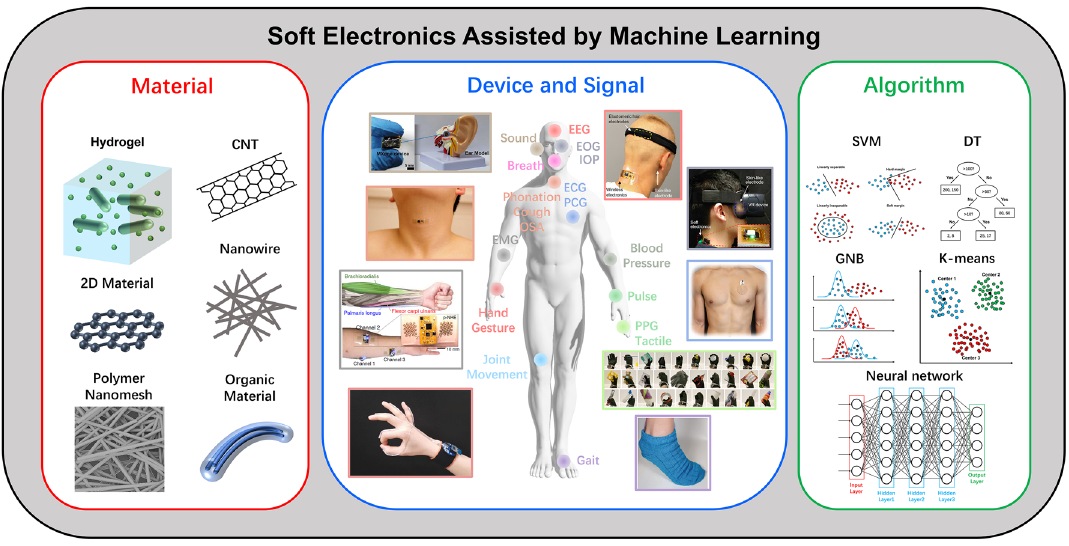
Fig. 1 Many new soft materials (2D material, CNT, nanowires, polymer nanomesh, hydrogel, etc.) have been applied to monitor physiologi- cal signals, such as EEG, EOG, IOP, breath, ECG, joint movement, blood pressure, pulse, photoplethysmography (PPG), EMG, and gait. The soft physiological monitoring system can be more and more intelligent assisted by algorithms such as SVM, DT, GNB, K-means, and neu- ral network. Reproduced with permission [26–29]. Copyright (2016), (2020), (2022), American Association for the Advancement of Science. Reproduced with permission [30–33]. Copyright (2019), (2020), (2021), Nature Publishing Group. Reproduced with permission [34]. Copyright (2020),